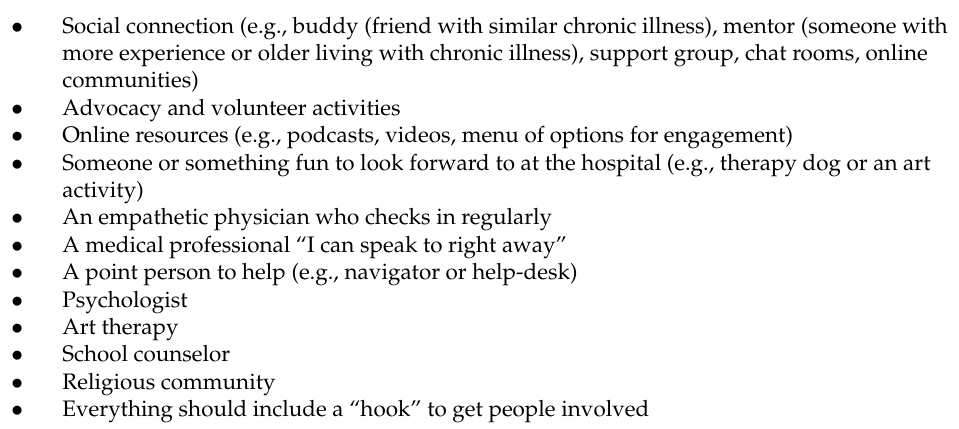
Figure 2. Summary of hope promotors and inhibitors. The comprehensive list of factors that influence hope derived from the participants were organized by promoters, inhibitors, and level of influence. The items selected by the participants as being of greatest importance are presented here. Table 2. Specific interventions to promote hope. Patients and caregivers developed the list through structured brainstorm and discussion over a series of eight focus